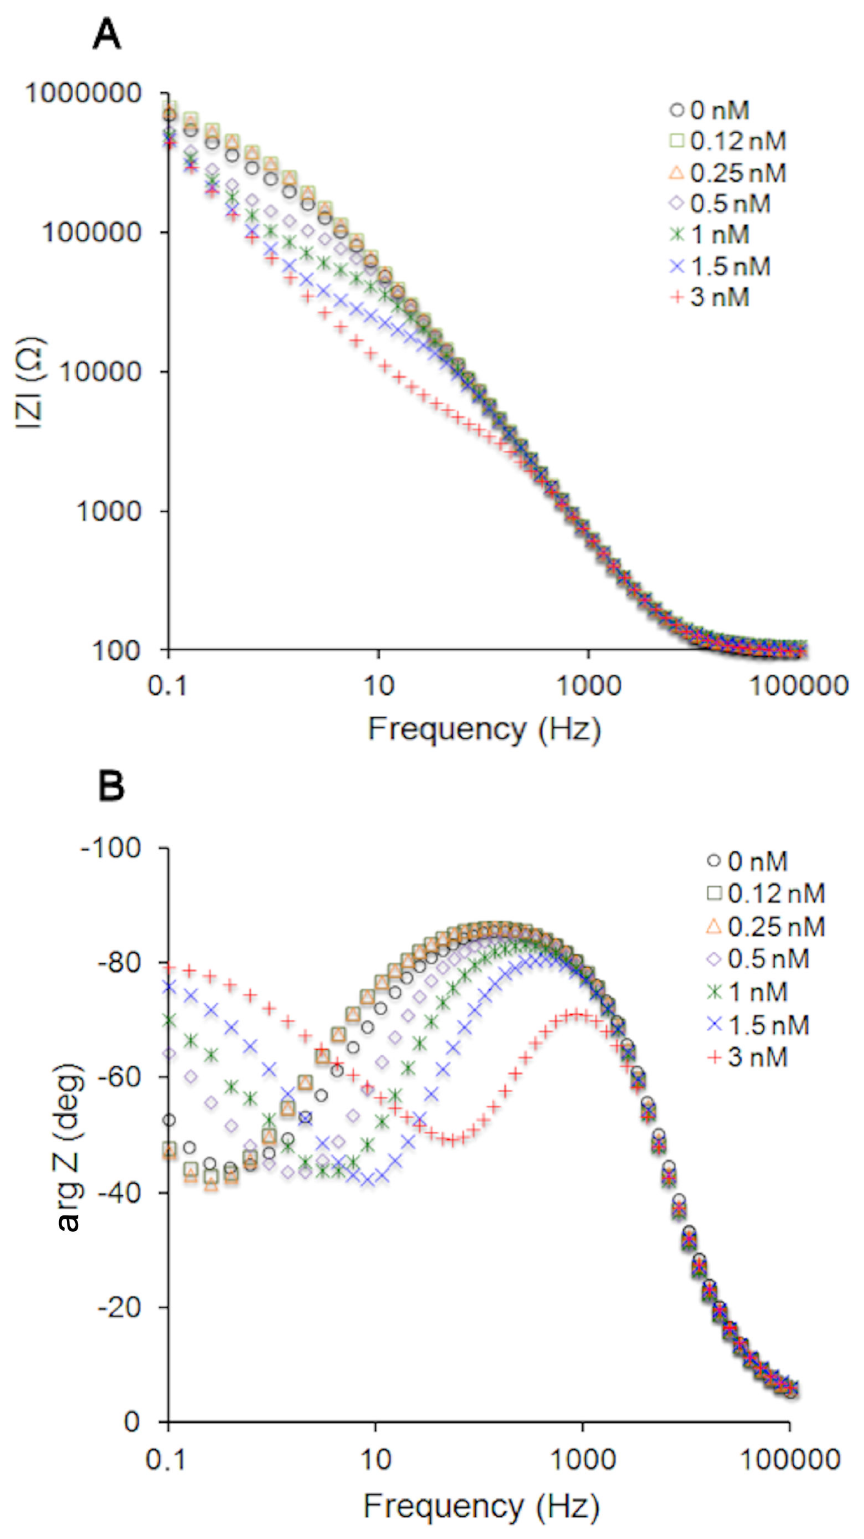
Figure 1. Impedance Bode plots of DOPC/CHOL40% tBLMs upon exposure to rVLY solutions of different concentrations. Exposure time 30 min. (A) Impedance magnitude. (B) Impedance phase. doi: 10.1371/journal.pone.0082536.g001 PLOS ONE |